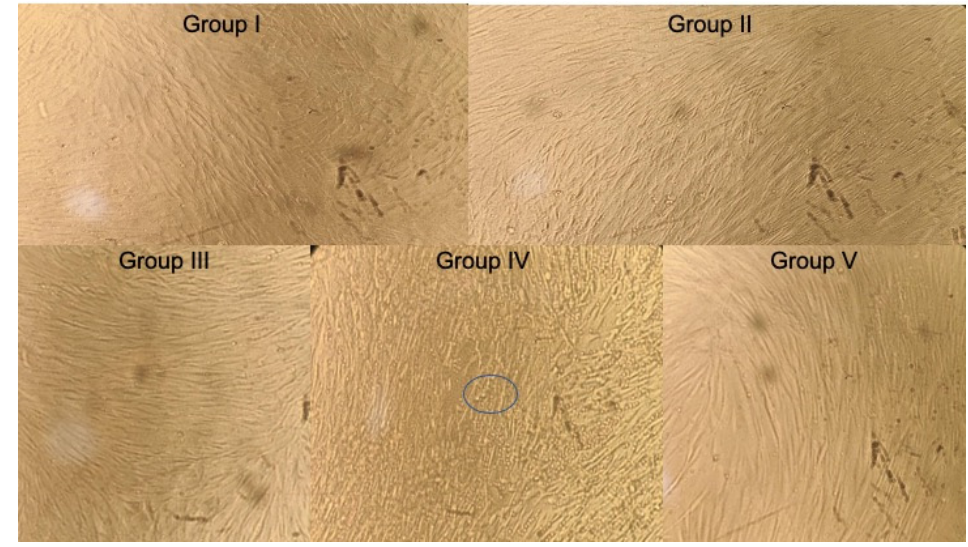
Figure 3. Histological assessment of MTT assay of hDPSCs treated with groups after 72 h. Circle represents living stem cells in cluster form.